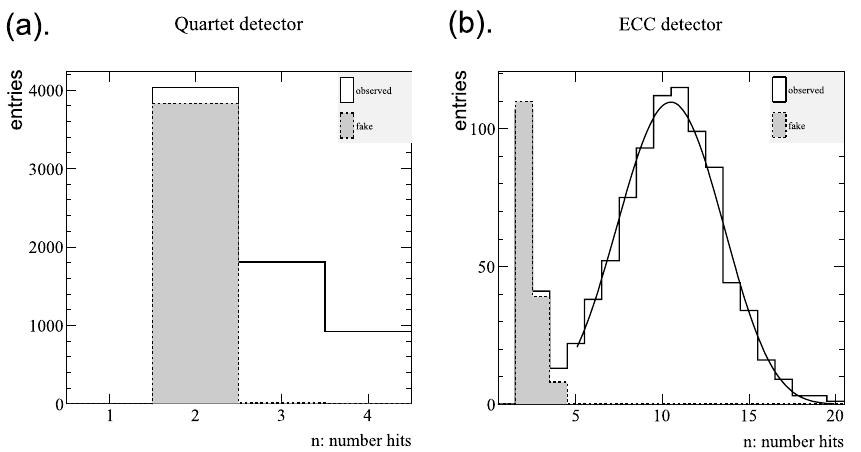
Fig. 7. (a) Number-of-hits distribution among the four films in the quartet detector for tracks with inclination 0 . 2 ≤ θ Q ≤ 0 . 262. The shaded histogram shows the probability that the tracks recorded during transportation are linearly aligned by chance and mistakenly identified as signals (fake signals). (b) Number-of-hits distribution among the 20 films in the ECC detector for tracks with inclination 0 . 2 ≤ θ ≤ 0 . 317, fitted with a beta-binomial distribution.